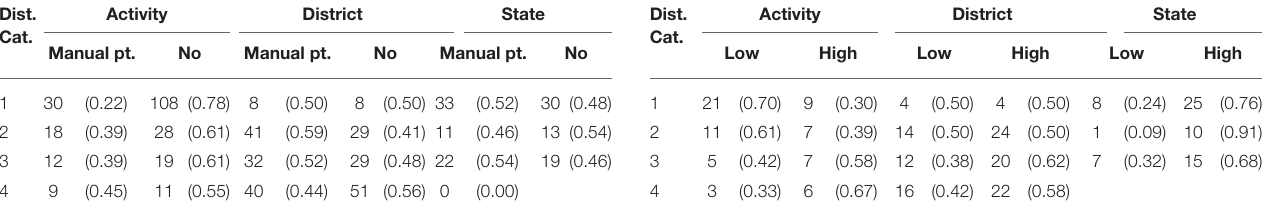
TABLE 7 | Raw frequencies (proportion) of manual points at the activity, district, and state scales. Dist. Activity District State Cat. Manual